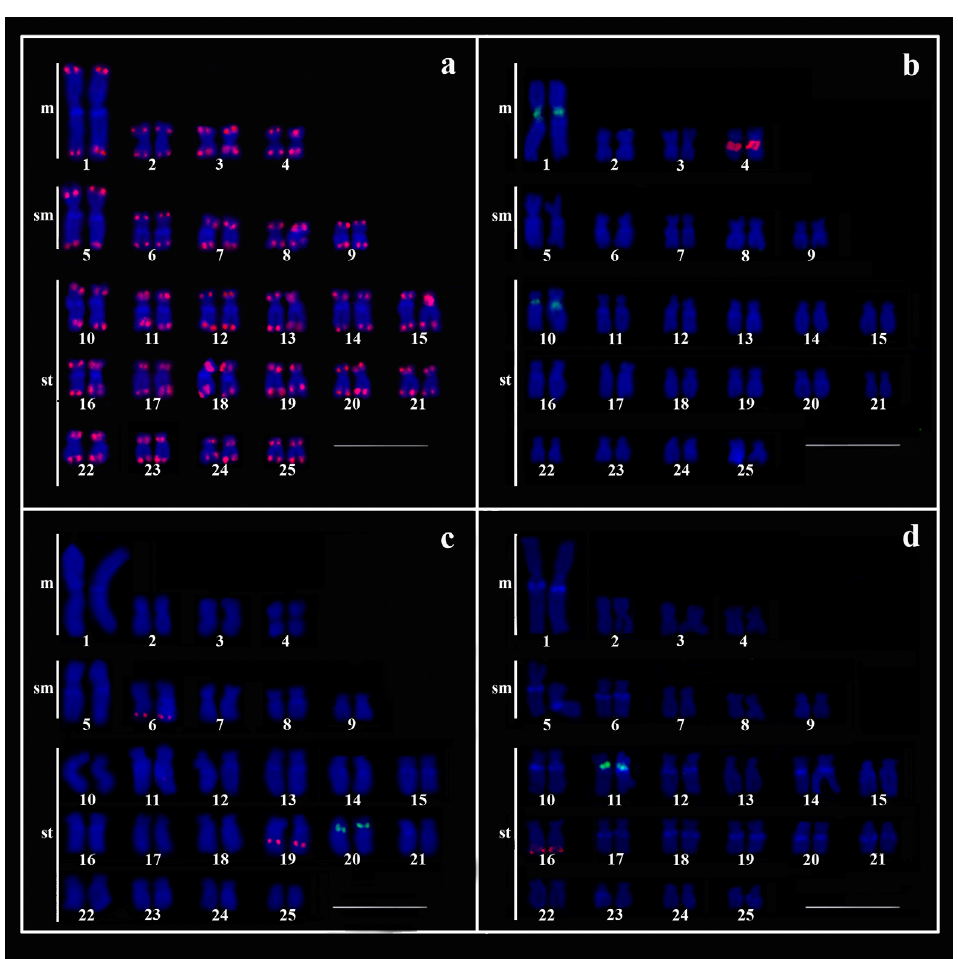
Figure 3 ‒ Karyotypes of males of Hollandichthys multifasciatus arranged after FISH mapping of (TTAGGG)n sequences (red signals) (a) ; (b) dual- color FISH with 5S (green signals) and 18S rDNA (red signals) sequences; (c) dual-color FISH with U1 (green signals) and U2 snDNA (red signals) probes and (d) dual-color FISH with U6 (green signals) and U4 snDNA (red signals) probes. The chromosomes were counterstained with DAPI (blue). Scale bar = 10